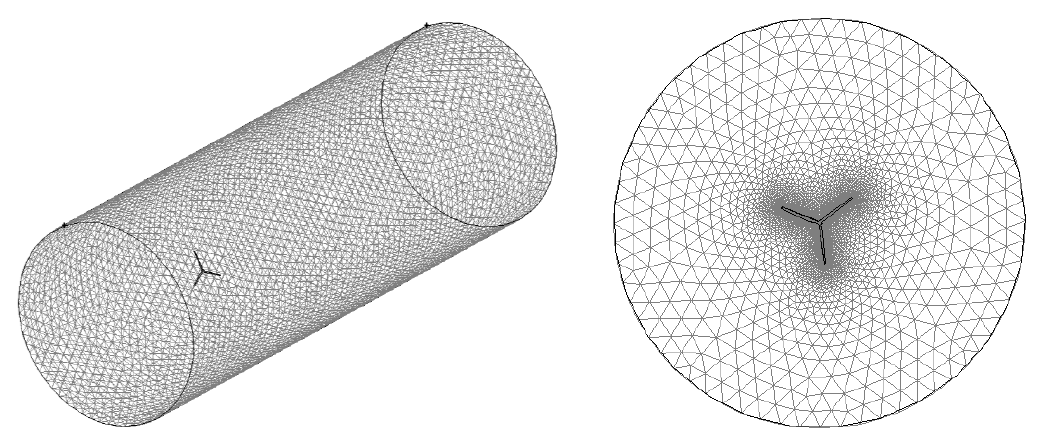
Figure 4. The numerical model of the scaled wind turbine blade. ( a ) The whole 3D computational zone ( left ); ( b ) The grids slice near blades ( right ).